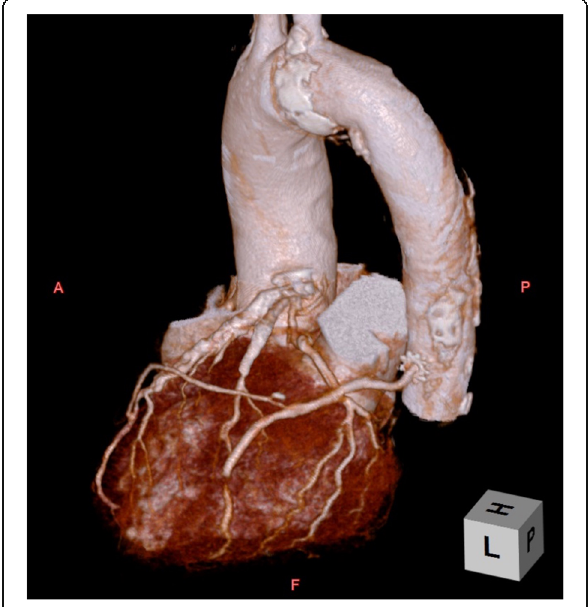
Fig. 4 Postoperative three-dimensional coronary computed tomography angiography shows patent bypass